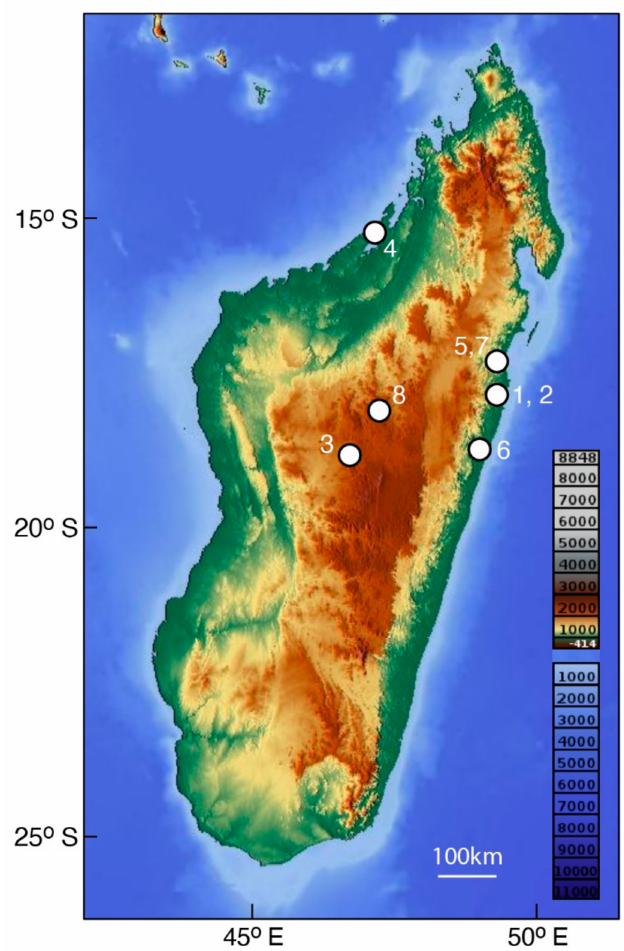
Figure 1. Sampling sites in Madagascar for the 262 DNA barcode records of Oreochromis spp. analyzed in this study. Site 1, O. niloticus GIFT strain at Matera ( − 18.0433, 49.3682); Site 2, O. niloticus GIFT strain at Tamatave ( − 18.449, 49.3987); Site 3, O. niloticus local strain at Ampefy ( − 19.0408, 46.7363); Site 4, O. niloticus JICA strain at Mahajunga ( − 15.6932, 46.3193); Site 5, O. niloticus local strain at Fenerive ( − 17.3666, 49.3961); Site 6, O. niloticus local strain at Brickaville ( − 18.8172, 49.0674); Site 7, O. mossambicus local strain at Fenerive ( − 17.3632, 49.3992); Site 8, O. macrochir local strain at Milasoa ( − 18.2224,